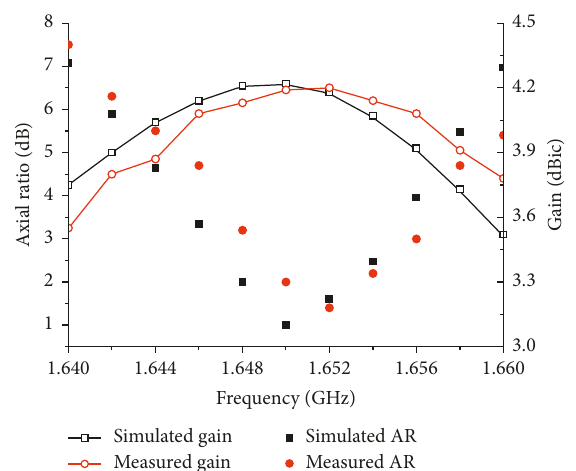
Figure 15: The ARs and CP gains versus frequency at the boresight